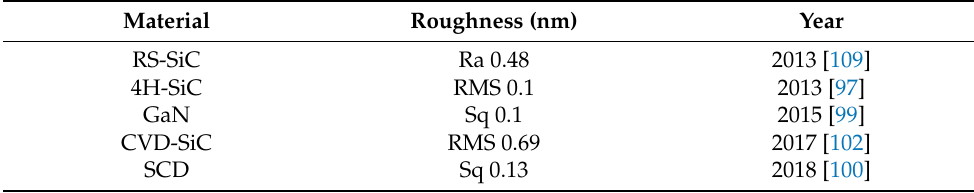
Table 3. The ultimate roughness achieved with PAP for different